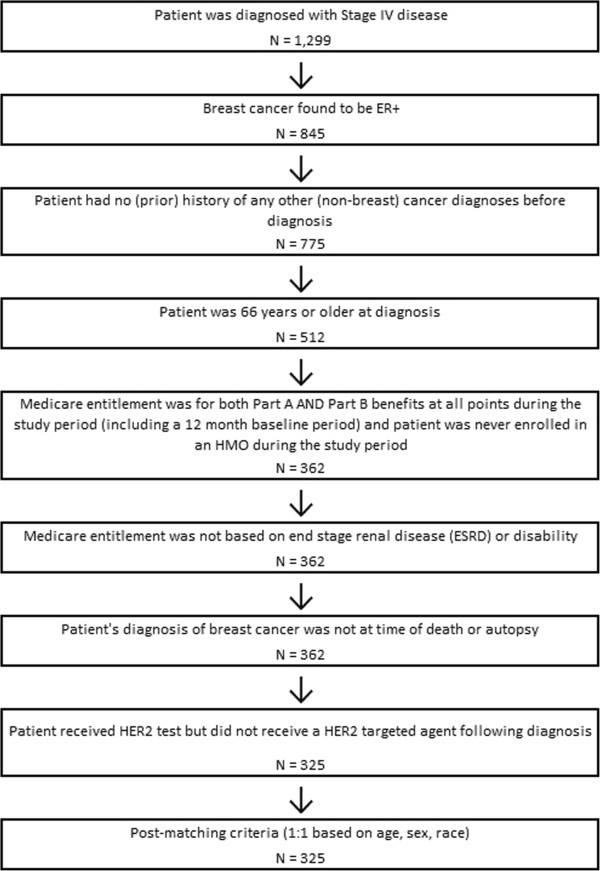
Patient selection.